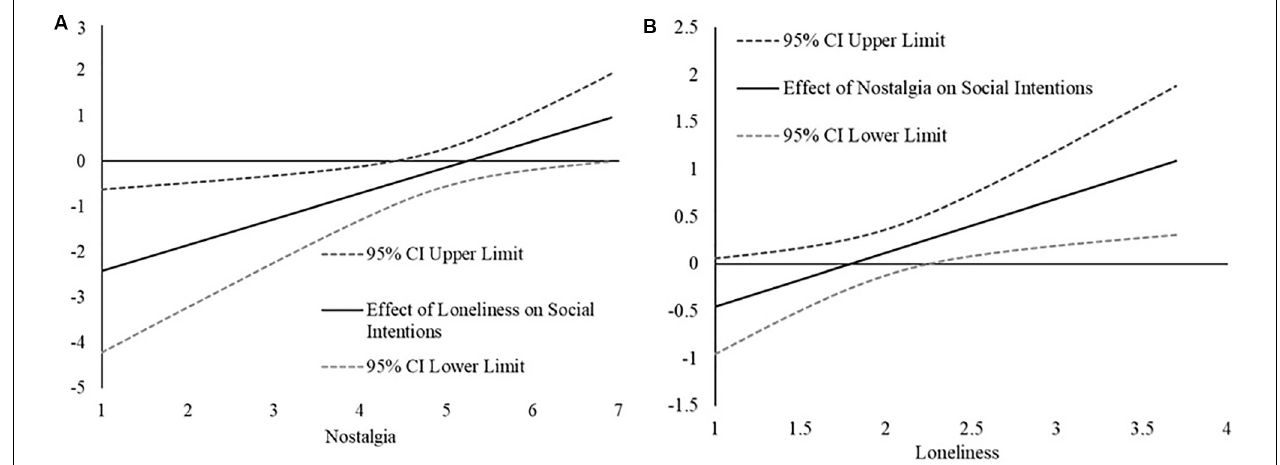
FIGURE 4 | (A) The plot represents the estimated relation between loneliness and intentions for participating in social research ( y -axis) across the range of nostalgic feelings ( x -axis) in Study 3. The relations are considered statistically significant if the confidence intervals for the effect (CI) do not contain 0. (B) The plot represents the estimated relation between nostalgic feelings and social intentions ( y -axis) across the range of loneliness scores ( x -axis) in Study 3. The relations are considered statistically significant if the confidence intervals for the effect (CI) do not contain 0.